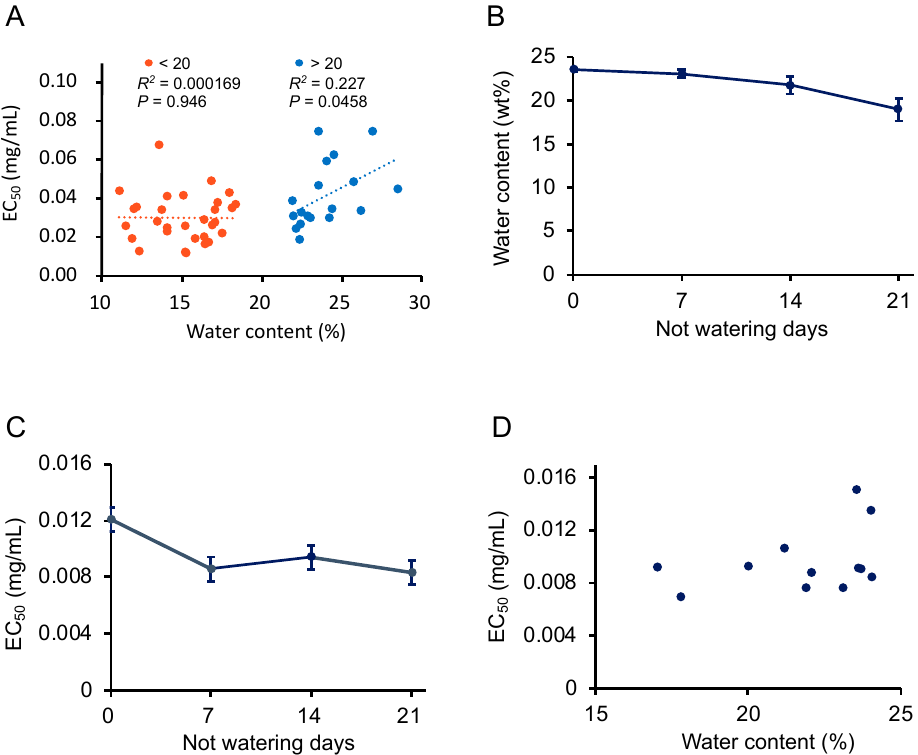
Figure 8. Drying enhanced the A β aggregation inhibitory activity of Perilla frutescens var. crispa leaves. ( A ) Scatter plot of soil water content at harvesting and EC 50 of leaf extracts from P. frutescens